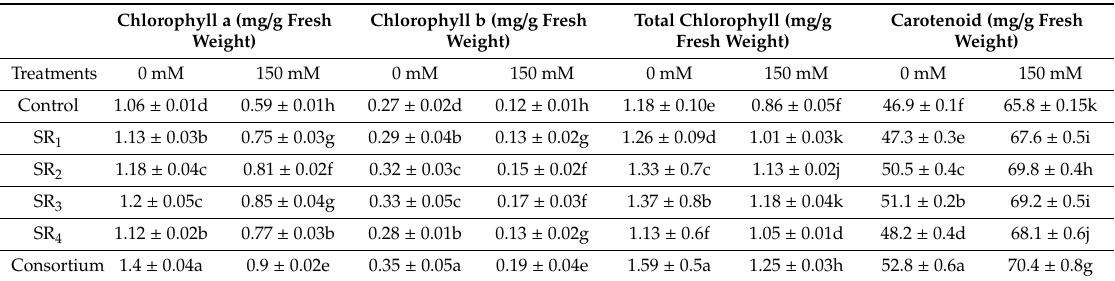
Table 5. E ff ect of halotolerant PGPR on the chlorophyll a, chlorophyll b, total chlorophyll, and carotenoid contents of wheat plants grown under salinity